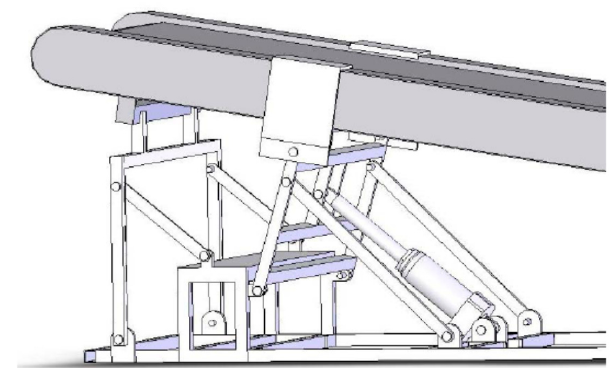
Figure 1. Treadmill elevator. A lever arm, powered by a mechanical jack, raises the rear end of